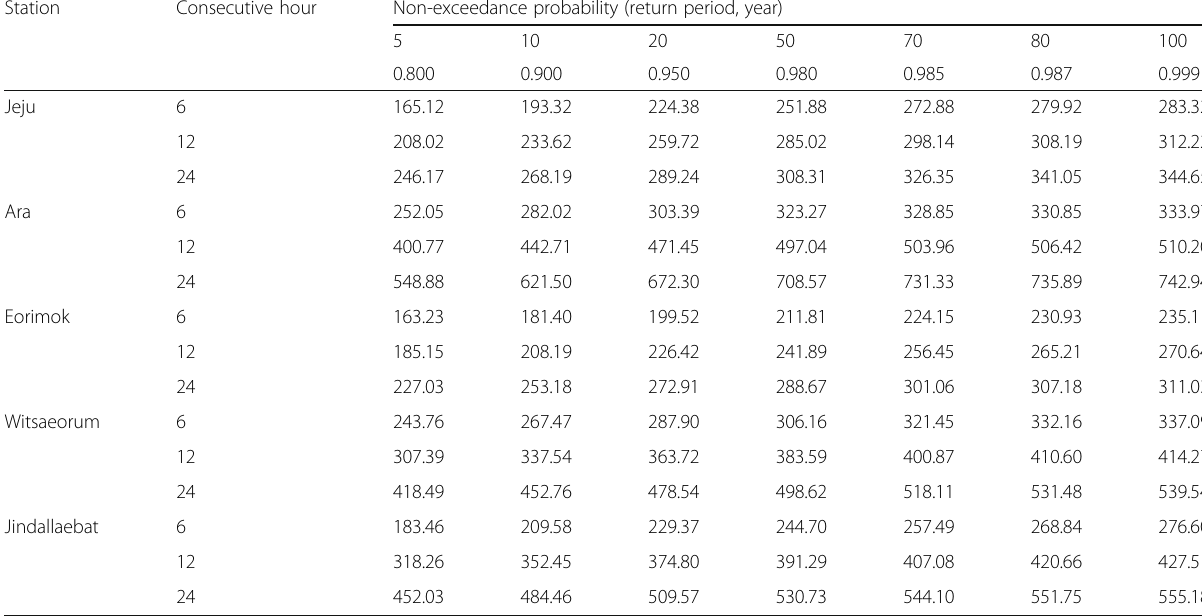
Table 5 Results of the consecutive hour (6-h, 12-h, 24-h) regional rainfall quantile for five station